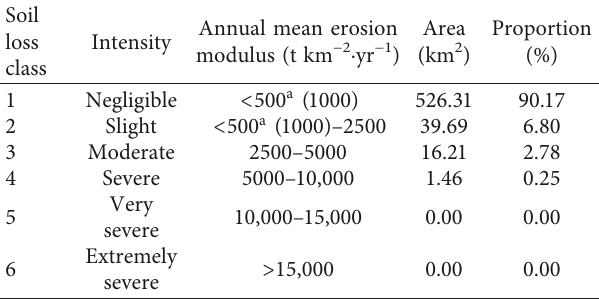
Table 4: Categories of soil erosion class and the area and pro- portion of each